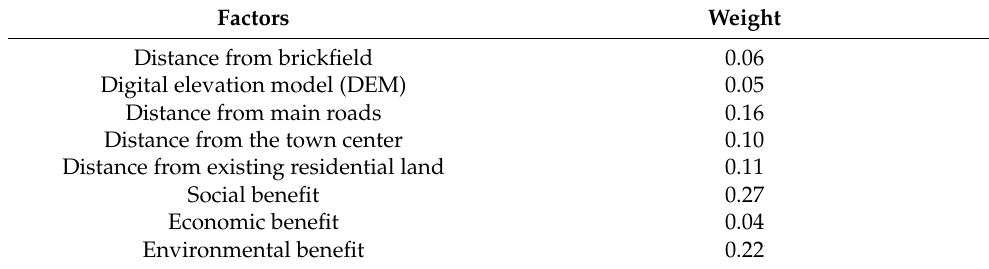
Table 5. Weights of different factors. Factors Weight Distance from brickfield 0.06 Digital elevation model (DEM) 0.05